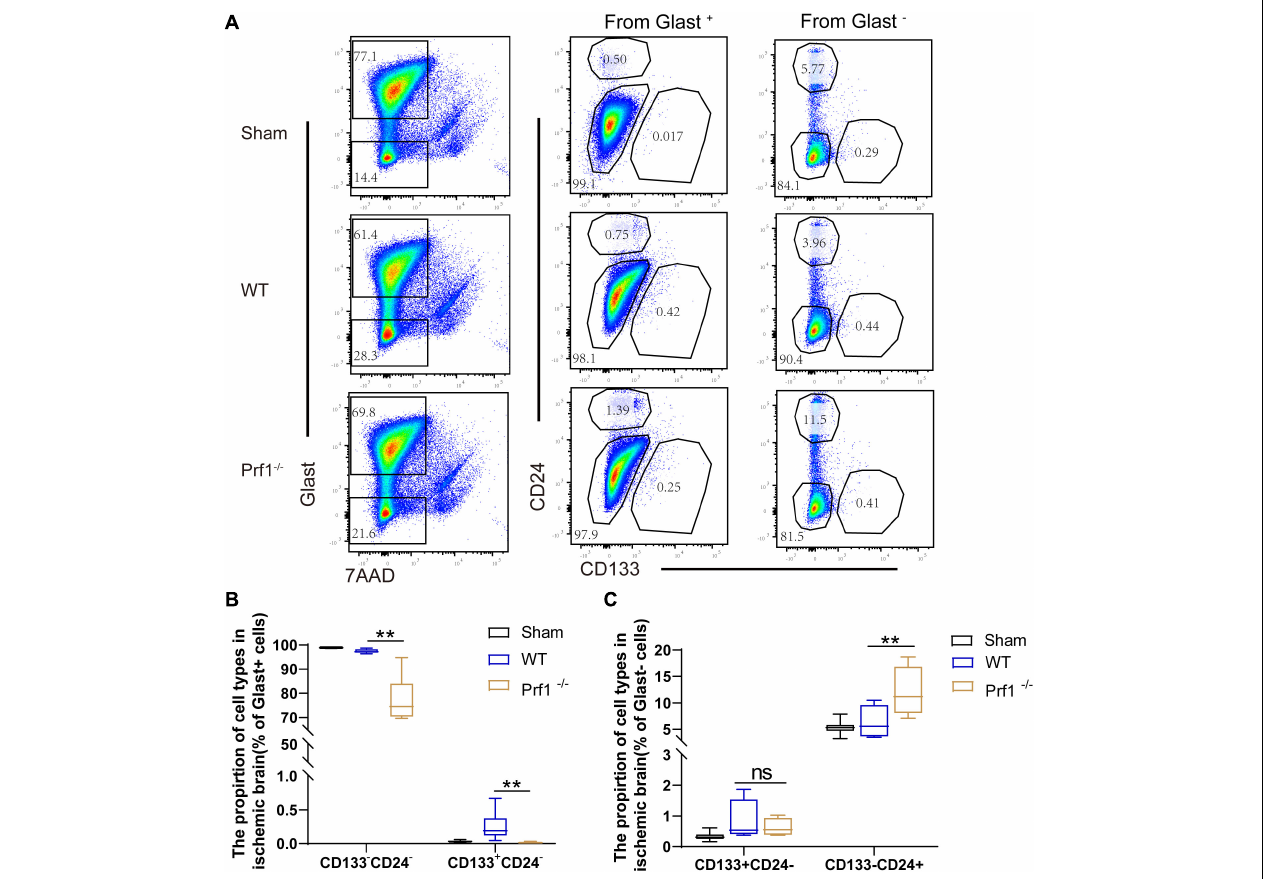
FIGURE 4 | Inhibition of perforin-mediated neurotoxicity facilitates neurogenesis. (A) Flow cytometry was used to detect astrocytes and neuron stem/progenitor cells by according to Glast and 7AAD expression, and these cells were divided into Glast + and Glast − subtypes 14 days after ischemia surgery and sham operation group in the focal ischemic brain area. Then, these three subtypes were divided into stem/progenitor cells according to CD133 and CD24 expression. (B,C) The box graph shows the numbers of mature astrocytes and glial progenitors. The data are shown as the median and the value of min to max; n = (6–10) animals in each group. Prf1 − / − mice vs. WT mice at each time point. ** P <